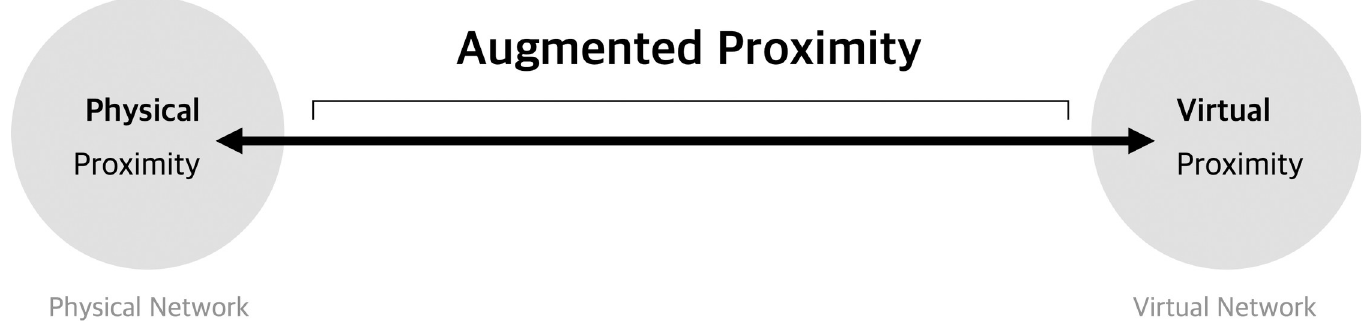
Fig 3. Simplified representation of the proximity continuum, showing